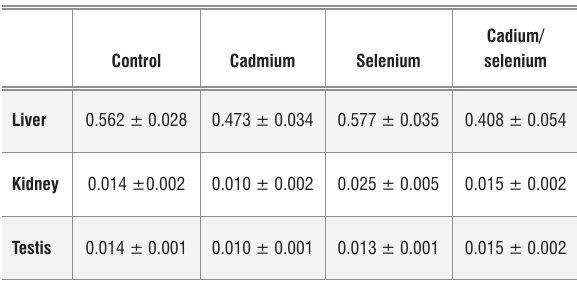
The ratio of superoxide dismutase to glutathione peroxidase rats after 15 days of exposure to saline (control) cadmium, selenium or cadmium and selenium